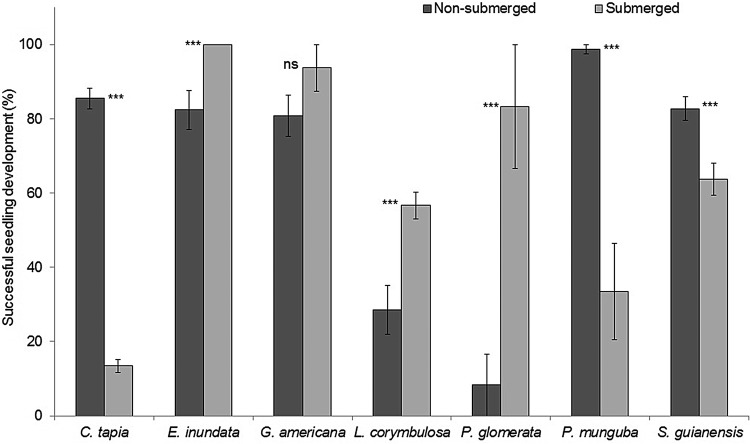
Successful seedling development in submerged (kept submerged in distilled water) and non-submerged (grown in commercial Bioplant® substrate soil) conditions expressed as a percentage of the number of germinated seeds for seven tree species of Central Amazonian floodplains. The asterisks indicate significant differences between the two treatments according to the REML test; ***P < 0.001. Bars are means ± standard errors.